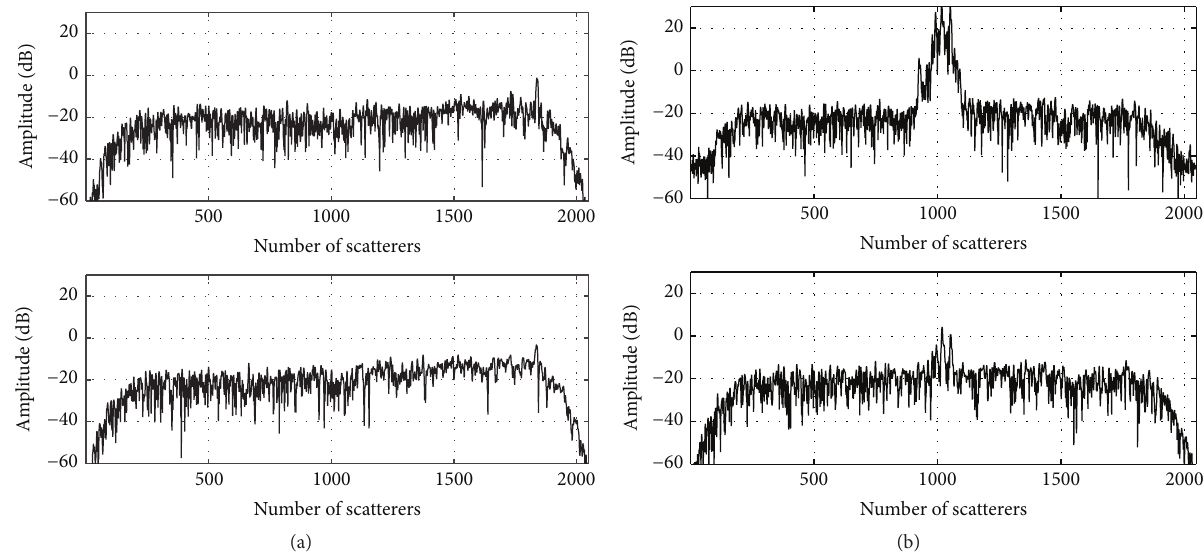
Figure 6: Comparison of range profiles in sum channel (top) and difference channel (bottom) for target missing and existing. (a) Range profiles without targets. (b) Range profiles of the target.